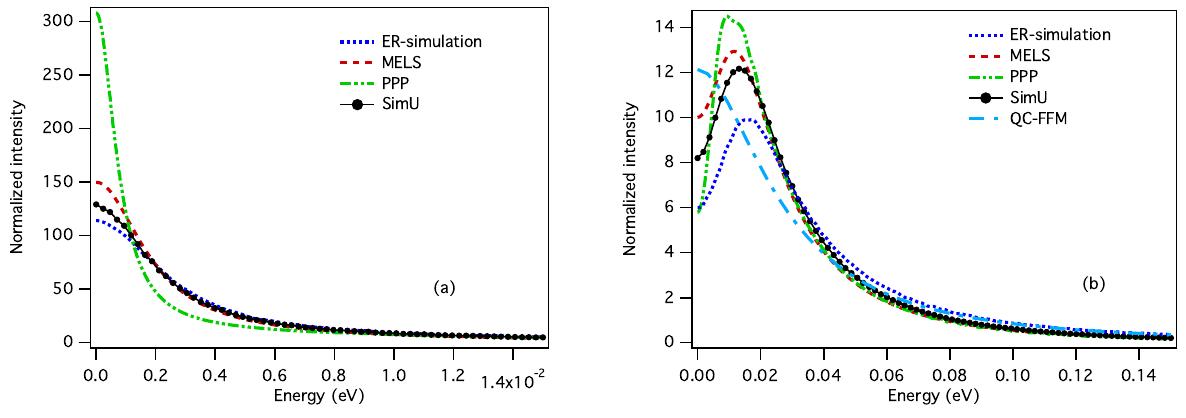
Figure 7. Spectral line shapes of the Lyman- α ( a ) and - β ( b ) line in a time-dependent field created by interacting protons at n = 10 19 cm − 3 and T = 1 eV. Comparisons of the results obtained by the different